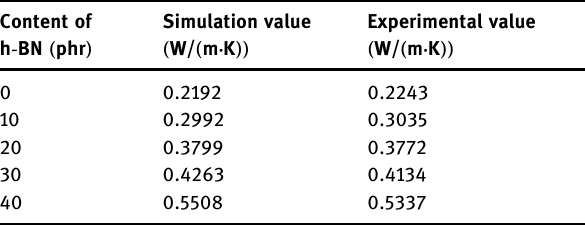
Table 3: Simulation and experimental value of thermal conductivity Content of